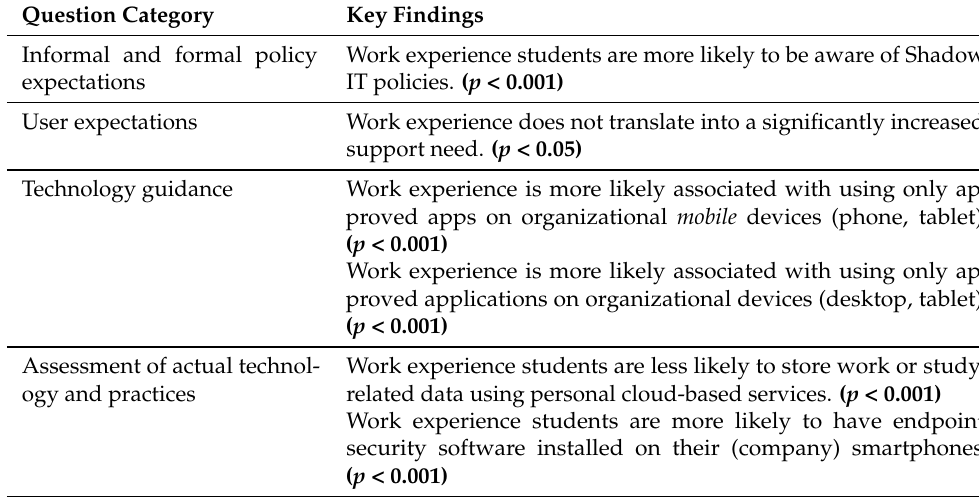
Table 7. Summary of key findings: Personal device usage and